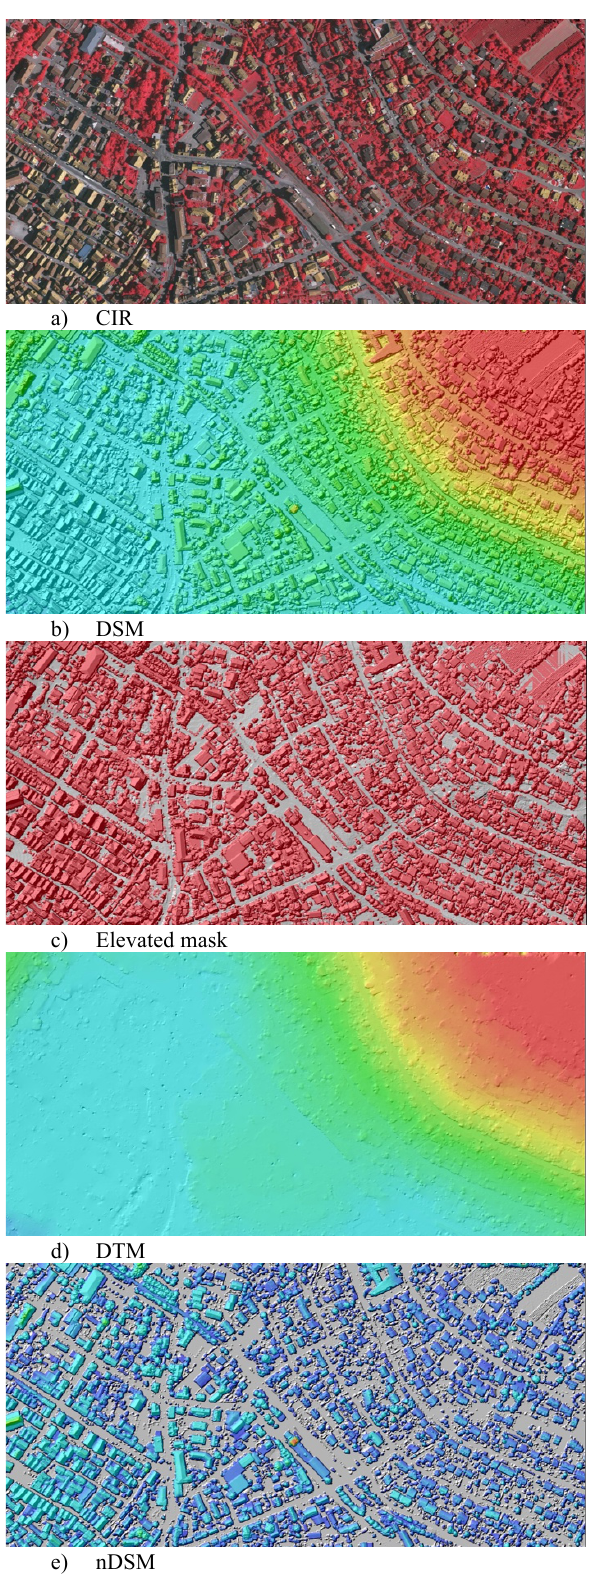
Figure 10. Vaihingen. From top to bottom: CIR, Ortho image, DSM, Elevated Mask, DTM, nDSM.